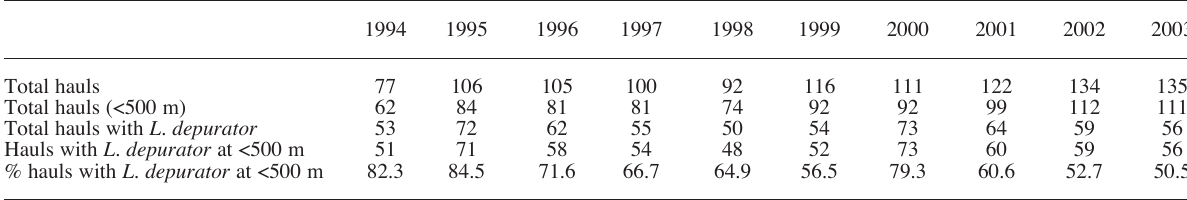
T ABLE 4. – Percentage occurrence of Liocarcinus depurator in waters less than 500 m depth along the Mediterranean coast of the Iberian Peninsula from 1994 to 2003.